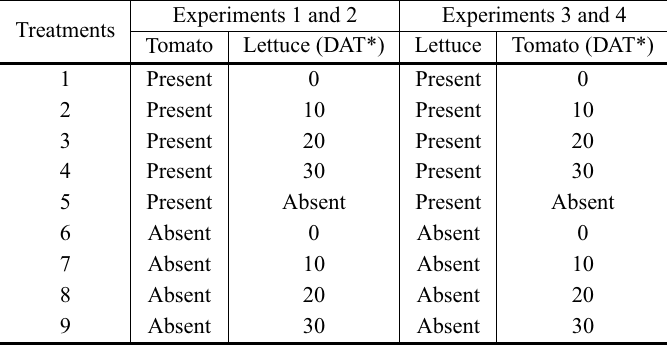
Characterization of the treatments of intercropping tomato and lettuce, with lettuce established after tomato (experiments 1 and 2) and tomato after lettuce (experiments 3 and 4).